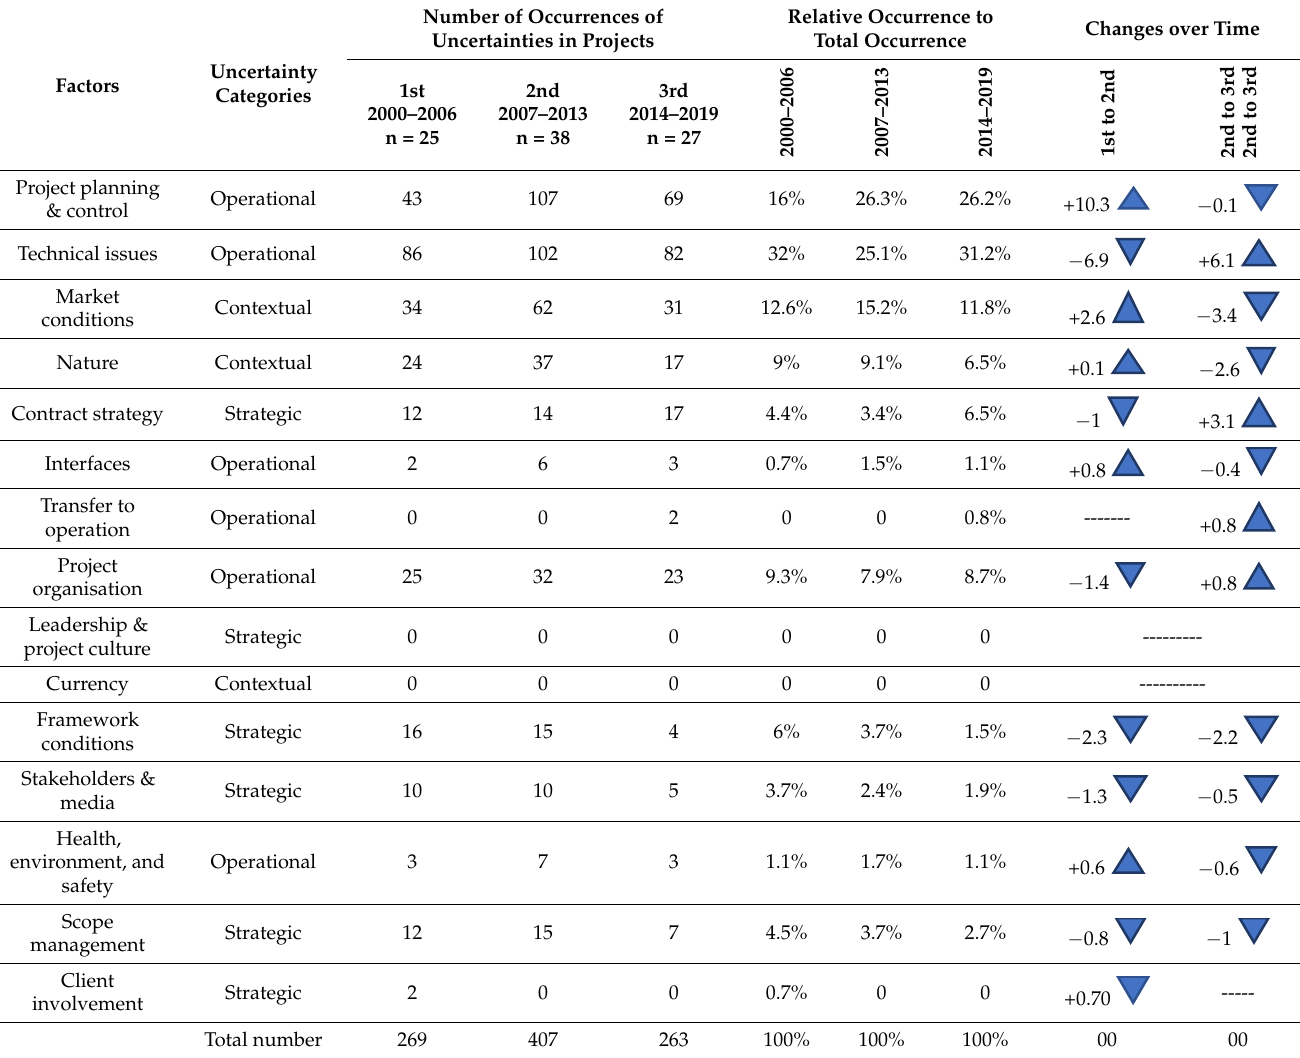
Table 4’s comparison of uncertainty factors at the single-factor level reveals that fac- tors with operational origins expanded from 59.1% (sum of operational uncertainties is highlighted in the year 2002–2006, 16% + 32% + 0.7% + 9.3% + 1.1% = 59.1%) in the first period to 62.5% in the second period and reached 69.1% in the third period. In contrast, uncertainty factors with strategic origins decreased from 19.3% in the first period to 13.2% in the second and 12.6% in the third. Uncertainty factors with contextual origins increased between the first and second periods but reduced in the third. From the first to the second period, uncertainty factors with operational origins from increased the first period, but uncertainties with strategic and contextual origins decreased. In the last period, an in- creasing share of operational uncertainty was concurrent with a reduction in strategic ones. These percentages express the relative weight of the different origins in the period.